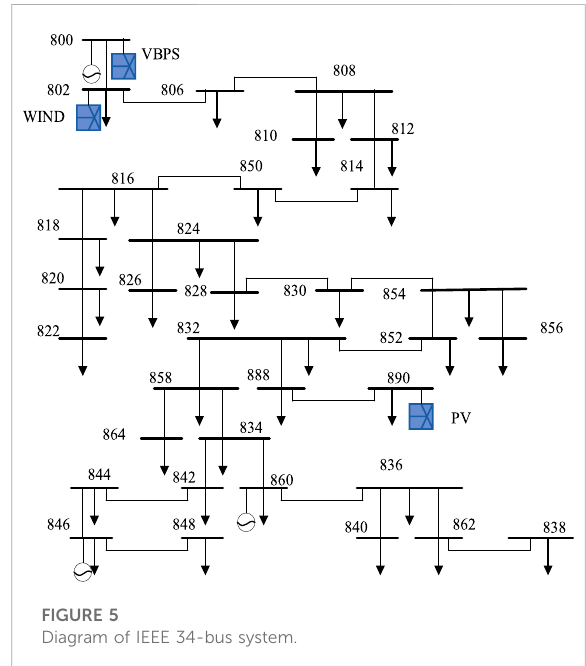
FIGURE 5 Diagram of IEEE 34-bus